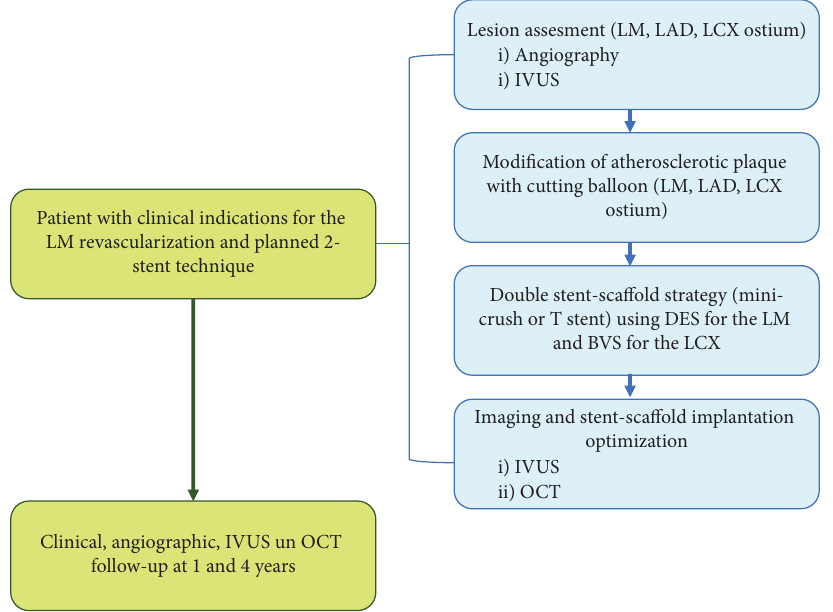
Figure 1: Study fowchart. Table 1: Baseline patient